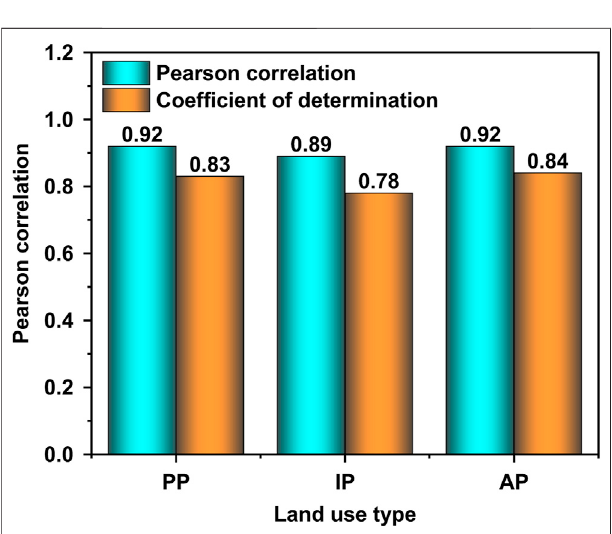
FIGURE 9 | The Pearson correlation values and coef fi cients of determination foreach land-use type. Thecomparison IllustratestheR2ofthe regression model with the R2 of the correlation of the predicted